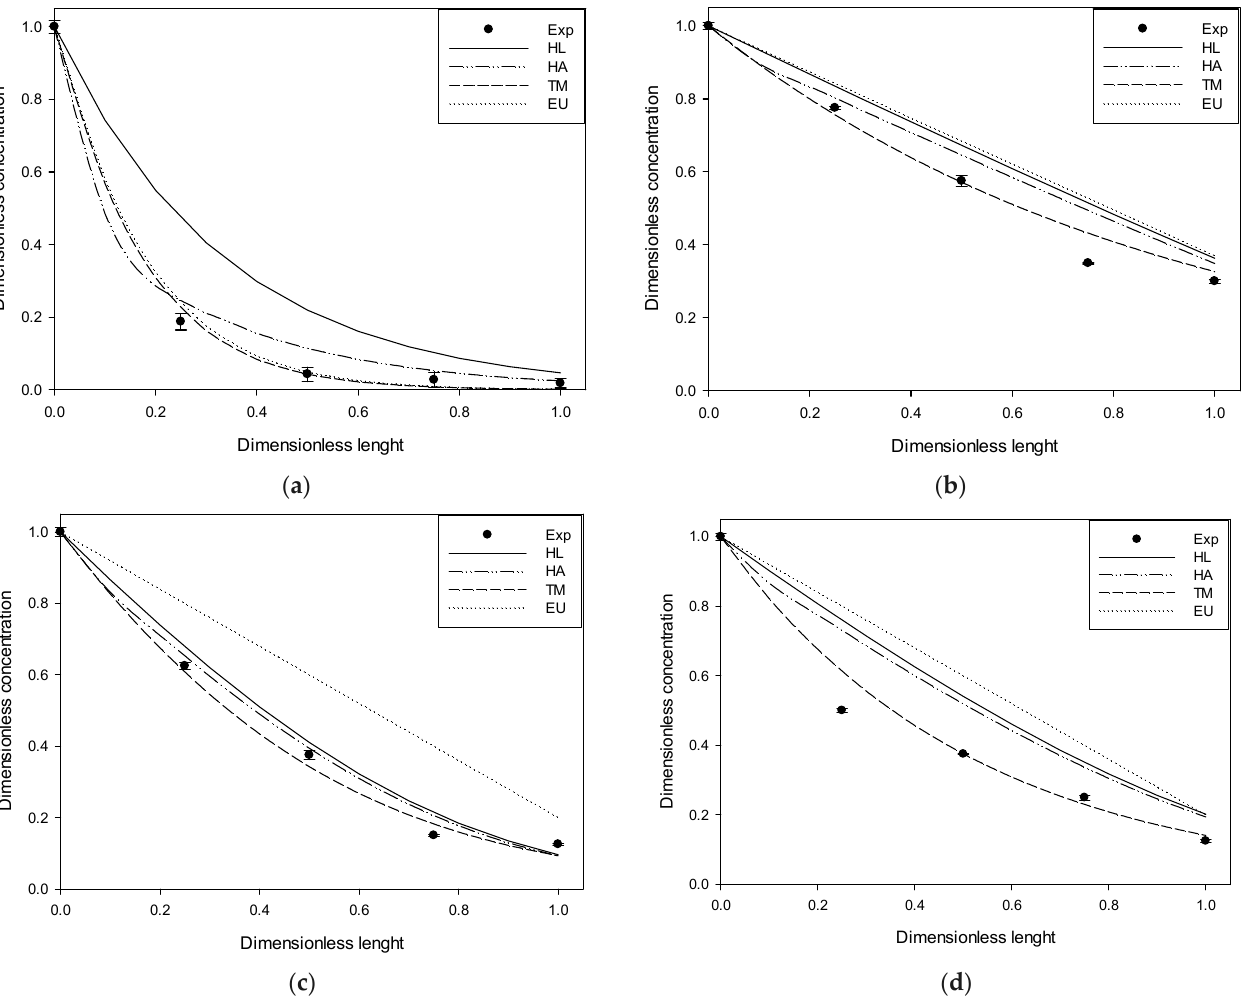
Figure 2. Nondimensional simulation results compared to experimental data with 4 ppm of input.